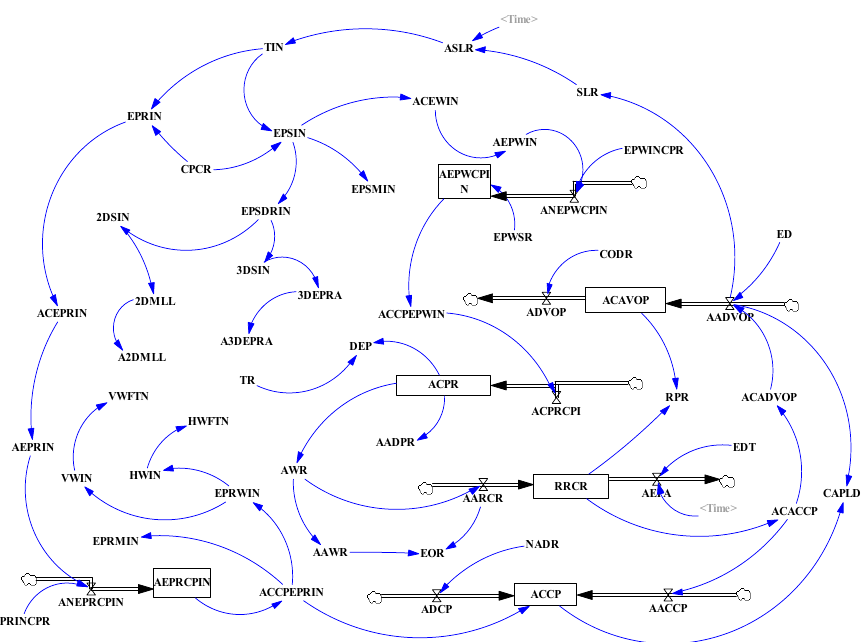
Figure 1. The System Dynamics model of natural gas exploitation and exploration.